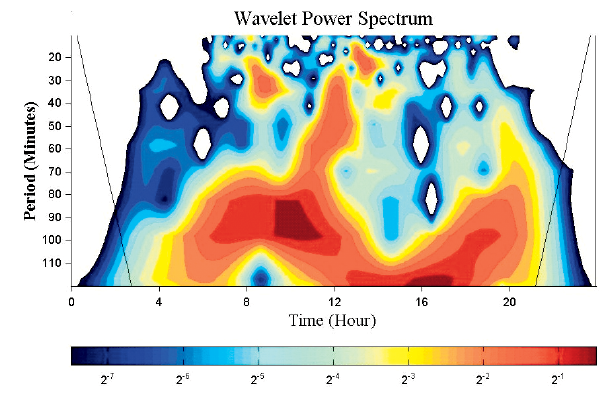
Fig. 10.8. Wavelet power spectra of electron concentration variation on 24 April 2001 at 230 km with sub- stantial intensification of wave-like activity in dawn and dusk hours at period range 70-100